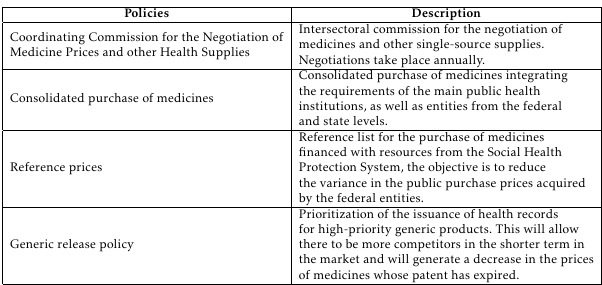
Table 1. Policies implemented at the federal